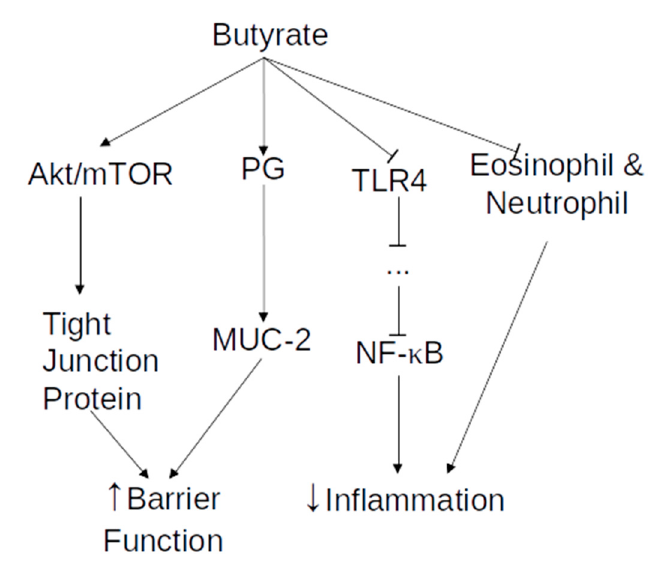
Figure 1. Overview of butyrate effects on the innate immune system. Arrow end—increase in activity or concentration. Blunt end—decrease in activity or concentration.